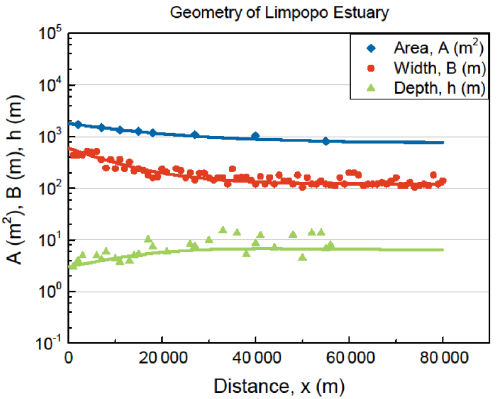
Figure 3. Geometry of the Limpopo Estuary, showing the cross- sectional area A (blue diamonds), the width B (red dots), and the depth h (green triangles) on a logarithmic scale as a function of the distance from the mouth. There is no inflection point, but the estuary converges exponentially towards the river cross section A f = 800m 2 , with a convergence length of